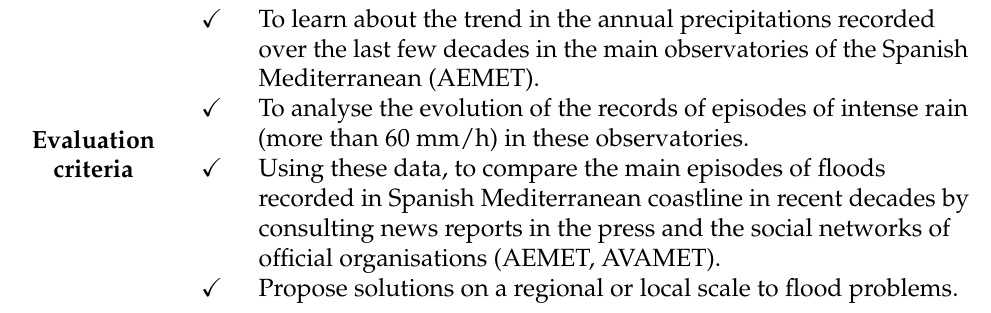
Table 3. Activities proposed for teaching the changes recorded in the precipitation of the Mediter- ranean coast (2nd of